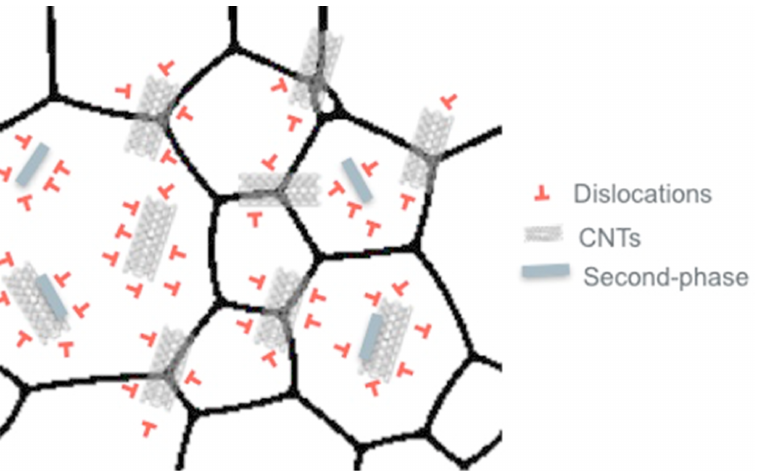
Figure 17. Schematic representation of the interaction between the dislocations, the CNTs and second phase